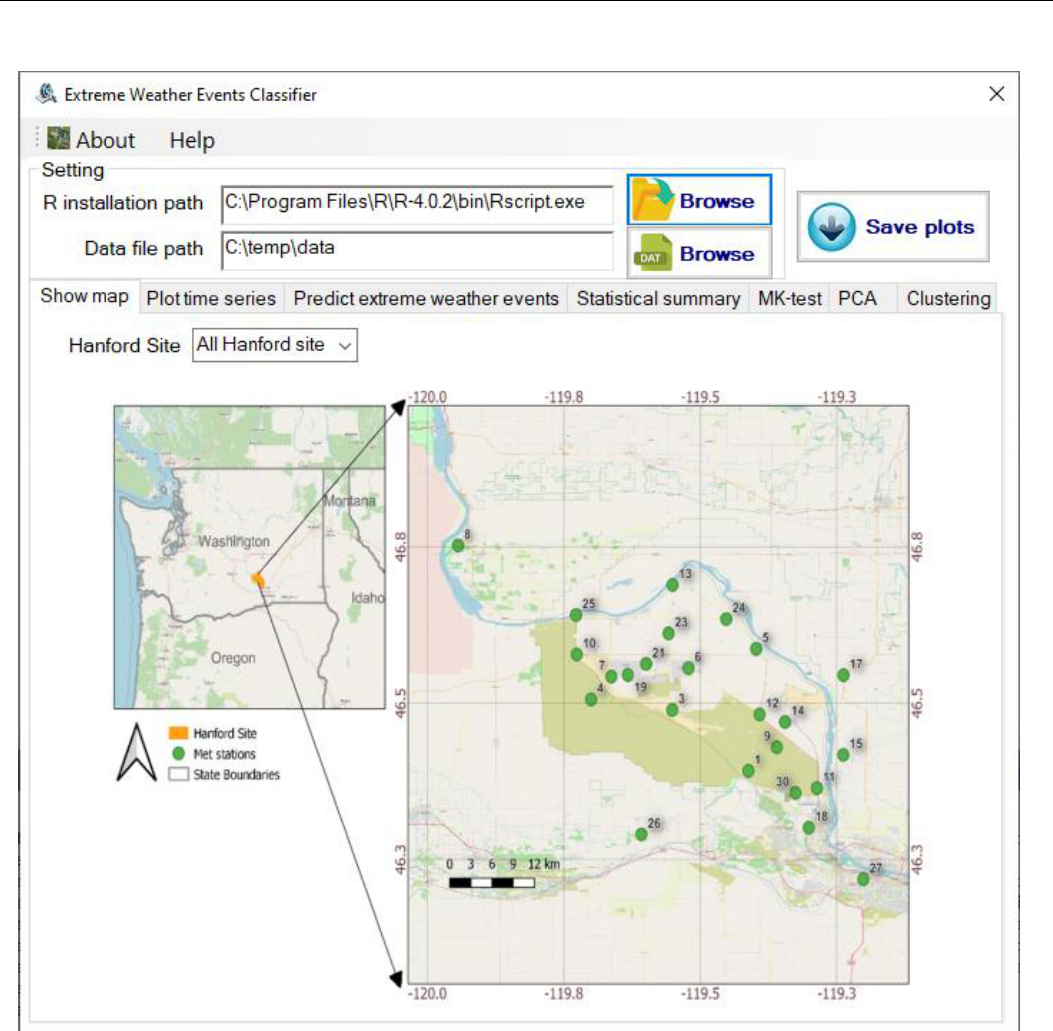
Figure 1. Distributions of meteorological sites at the Hanford Site as depicted in the GUI. Green dots indicate monitoring site location.